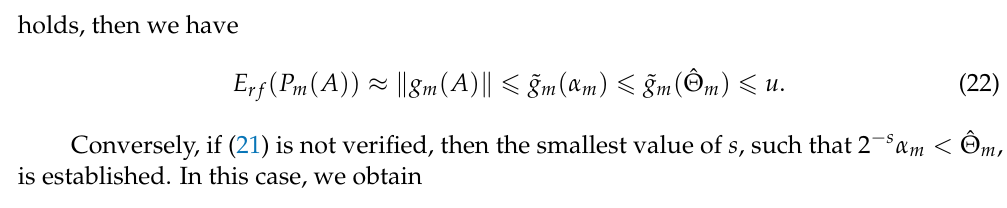
and ˆ Θ m , m k ∈ M , for E af ( P m k k m k Θ m